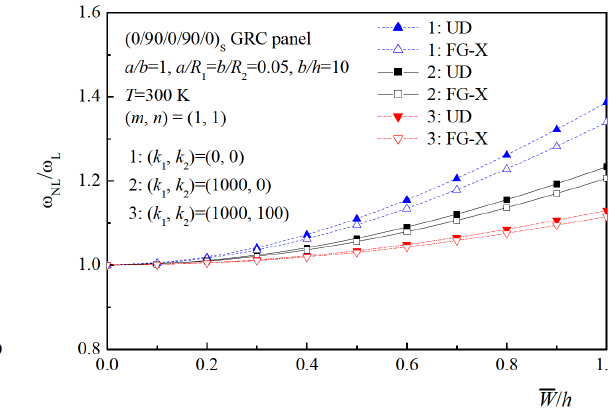
Figure 3: Frequency-amplitude curves for doubly curved (0/90/0/90/0) S GRC laminated panels with different graphene distribution patterns